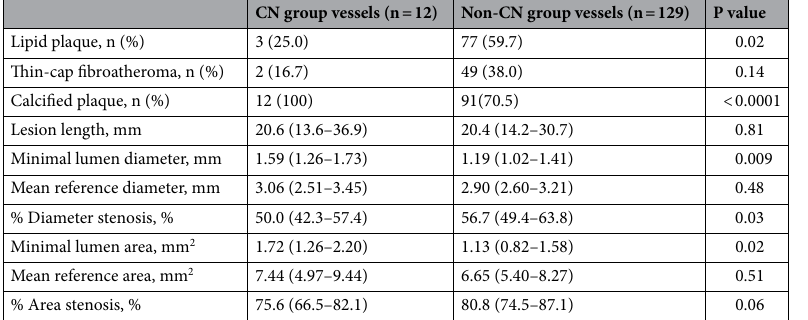
Table 2. OCT findings at PCI culprit vessel. Values are presented as numbers (%) or medians (interquartile ranges). CCTA coronary computed tomography angiography, CN calcified nodule, LAD left anterior descending, LCX left circumflex, LMT left main trunk, RCA right coronary artery.